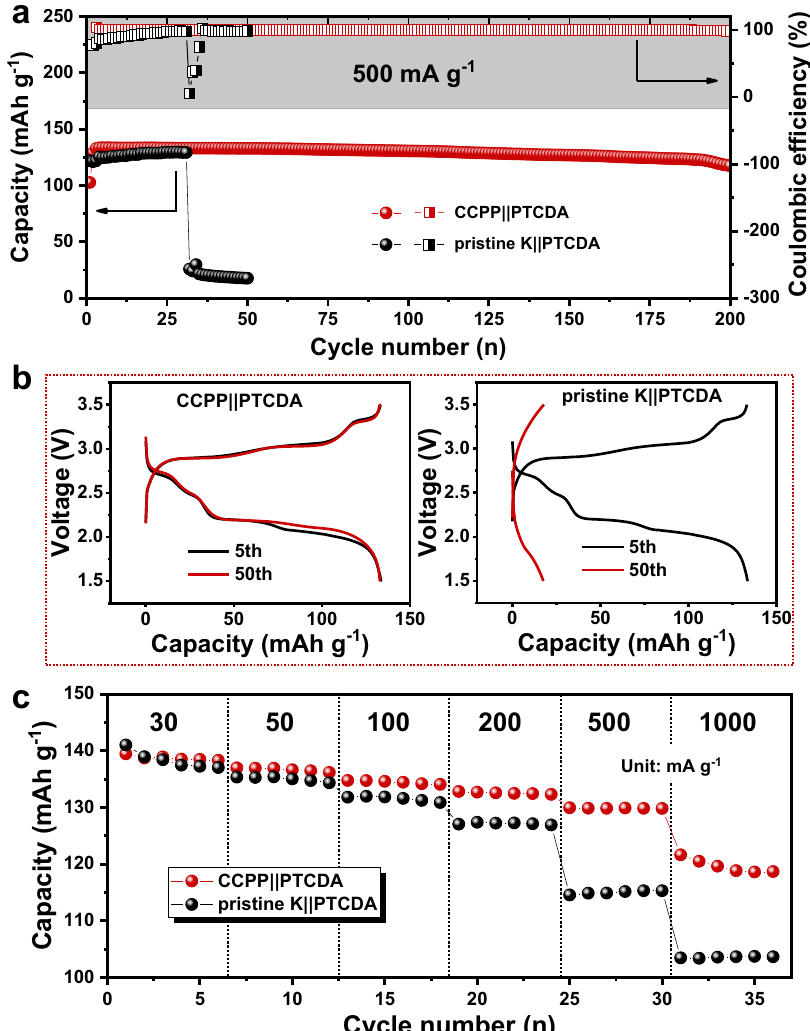
Fig. 6 Full-cell performances in the KPF 6 /EC:DEC electrolyte. a Long-term stability of CCPP||PTCDA and pristine K||PTCDA batteries at 500 mA g − 1 . b The 5th and 50th charge-discharge pro fi les of CCPP||PTCDA and pristine K||PTCDA at 500 mA g − 1 . c The rate performances of CCPP||PTCDA and pristine K||PTCDA cells. Source data are provided as a Source Data fi battery testing system with a constant temperature of 27±0.1°C (full cells) or room temperature (Symmetric cells). Electrochemical impedance spectroscopy (EIS) and Tafel plots of cells are characterized by using the electrochemical workstations (IVIUM-VERTEX. C, Netherlands, and CHI760E, China). The frequency range of the EIS is from 100,000 to 0.1Hz, as well as the disturbance amplitude was 0.005 V. Tafel plots and derived exchange current density obtained from linear sweep voltammetry tests in the range of − 0.3 V to 0.3V at 2 mVs − 1 . Electronic resistivity of SEI of CCPP is measured by a direct current – voltage curve on a Neware battery system. Herein, blocking electrodes with pristine K or CCPP sandwiched between two stainless steels are assembled. First, the blocking electrode is run at an open-circuit voltage for 20 s, then a constant current of 5 mA is applied for 80s. The calculation formula is: Where L is the thickness of SEI; I is the applied current; S is the contact area between the sample and stainless steel; U is the average voltage increase. Materials characterizations . Morphology images with EDS analyses are collected on Hitachi FE-SEM, S4800 at 5 KV and MIRA3 TESCAN (Hunan Navi New Materials Technology) at 10 KV with the exposure time to air below 20 s. The XRD patterns are recorded on a Bruker D8 Advance (Bruker AXS, Germany) with Cu K α radiation ( λ = 0.15418 nm). The sample is covered with kapton tape to ensure that the K-containing samples are not oxidized in the air during XRD